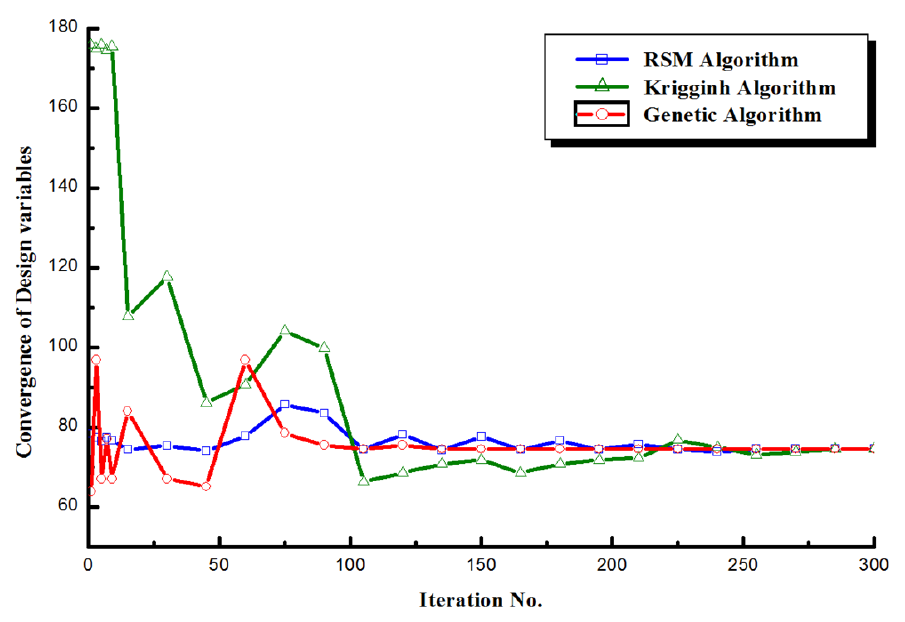
Figure 11. Comparison results of algorithms.